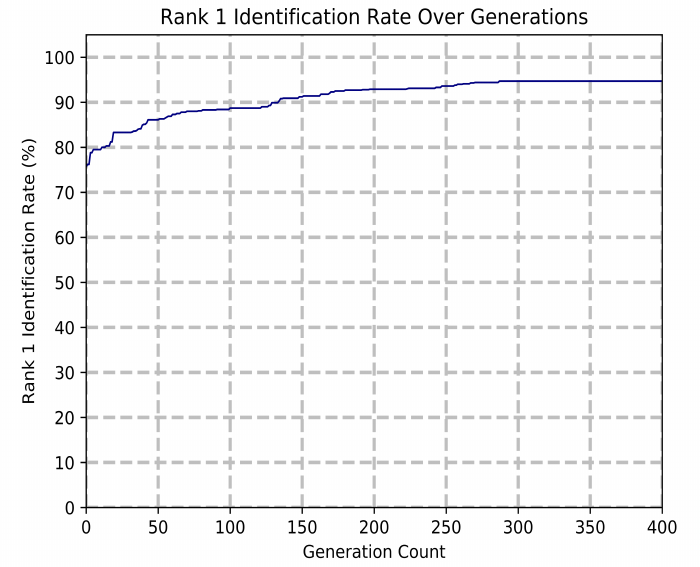
Figure 6. Model accuracy over a period of 400 generations.